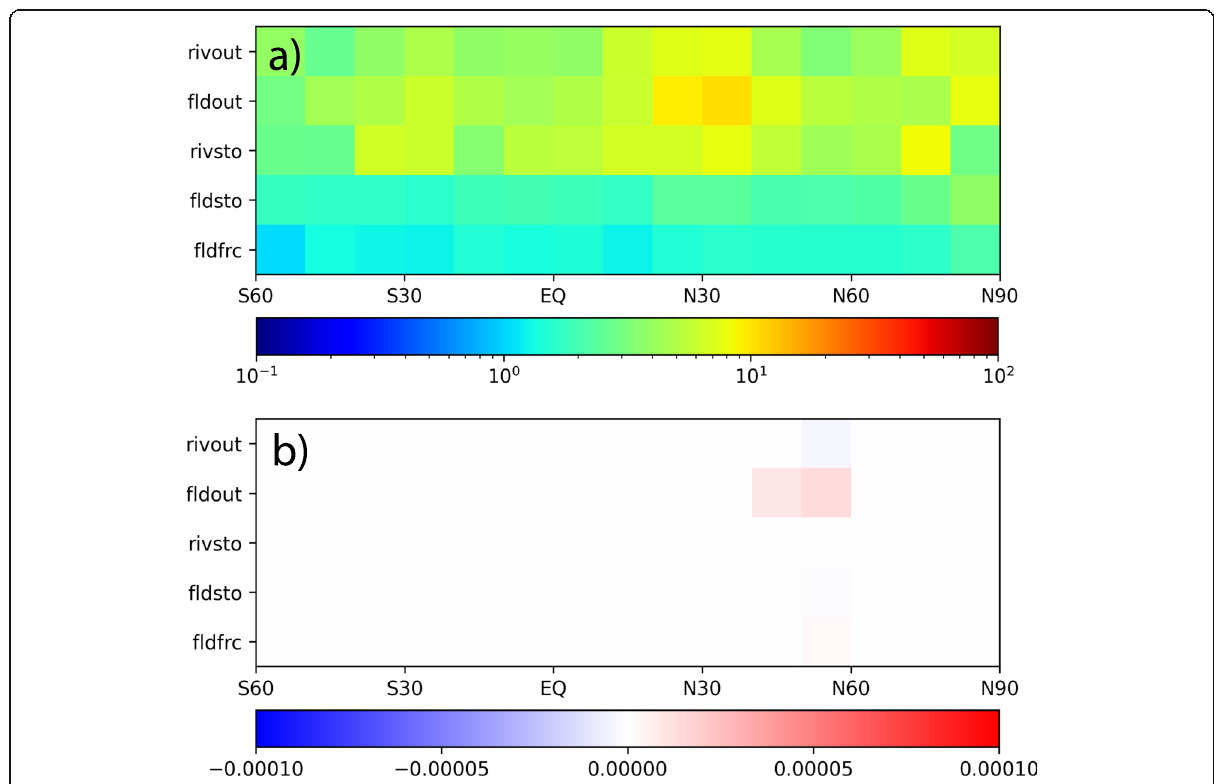
Fig. 9 a The standard deviation of uncoupled simulation normalized by mean. The vertical axis shows river discharge, flood-plain discharge, river storage, flood-plain storage, and flooded area fraction. The horizontal axis shows latitudes. b As in a but for the difference normalized by their mean